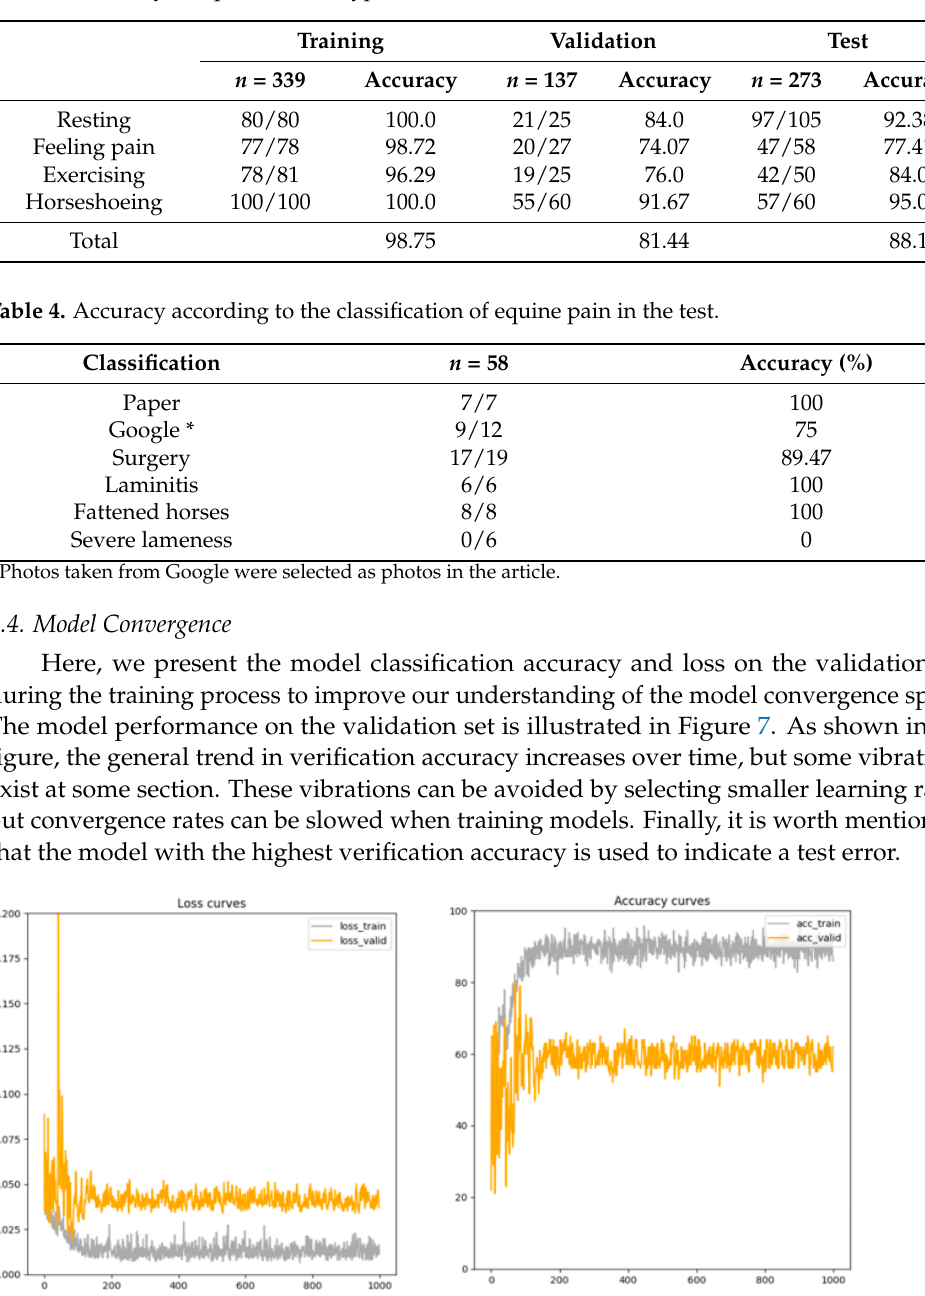
Table 3. Accuracy of equine facial keypoint detection classification.